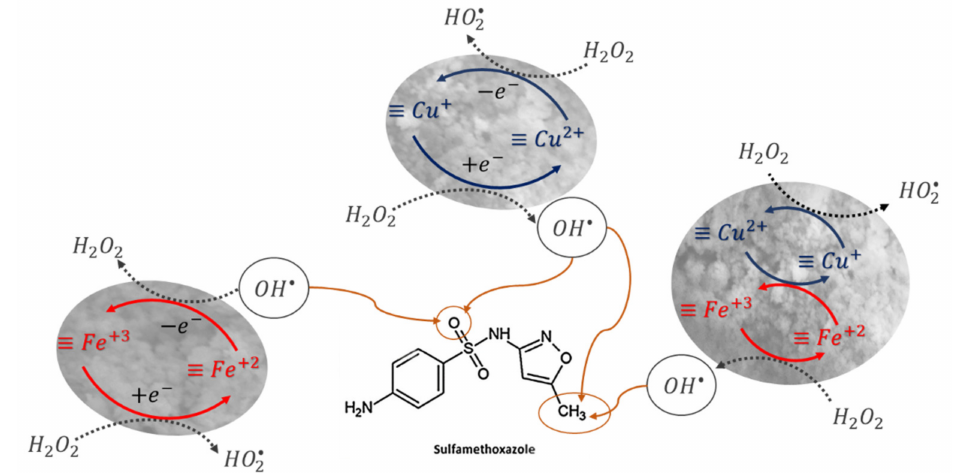
Figure 8. Graphical scheme of the reactions occurring on the Fe x Cu 1 − x (BDC) surface for SMX